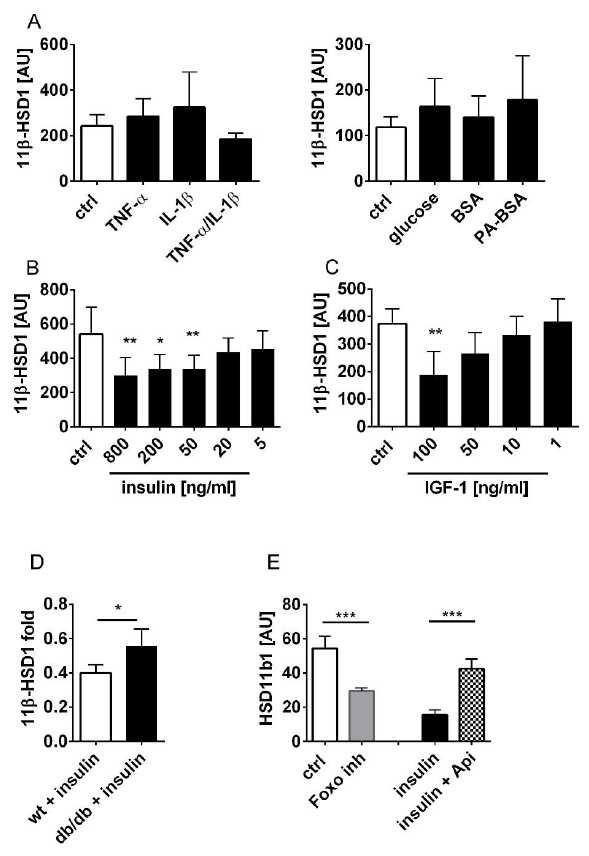
Figure 3. Insulin and IGF-1 down-regulate 11β-HSD1 expression in fibroblasts through PI3K/Akt signalling. ( A – C ) Murine fibroblasts were cultured in serum-free medium with TNF-α, IL1-β, TNF-α and IL1-β, high glucose, palmitic acid-BSA, BSA ( A ) or insulin ( B ) or IGF-1 ( C ). 11β-HSD1 gene expression normalised to Rplp0 was analysed by quantitative PCR. ( D ) 11β-HSD1 gene expression normalised to Rplp0 was analysed by quantitative PCR in fibroblast from wild-type (wt) and db/db mice. X-fold reduction of 11β-HSD1 expression by insulin is shown. ( E ) Fibroblasts were incubated with FOXO1 inhibitor (AS1842856), insulin, or insulin in the presence of PI3-kinase/mTOR inhibitor (Apitolisib), respectively. 11β-HSD1 gene expression normalised to Rplp0 was analysed by quantitative PCR. Unpaired t-test * p < 0.05, ** p < 0.01, *** p < 0.001. Api, Apitolisib; ctrl, control; inh, inhibitor; PA, palmitic acid; AU, arbitrary units.